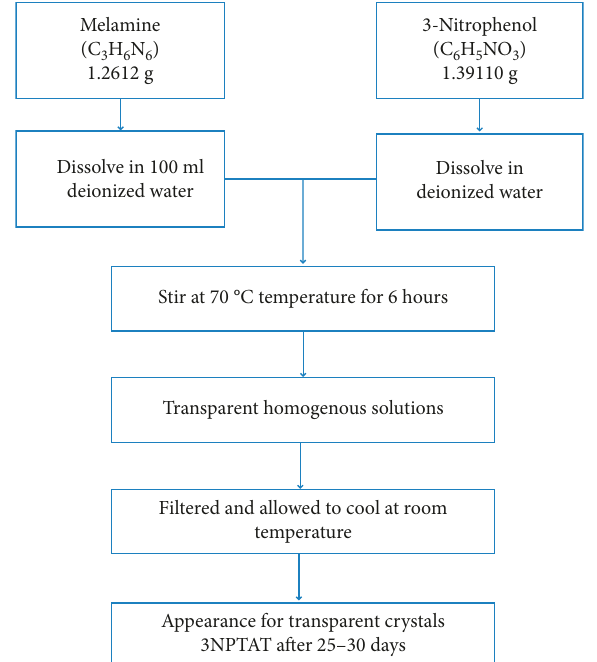
Figure 1: Synthesis flow chart of the 3NPTAT single